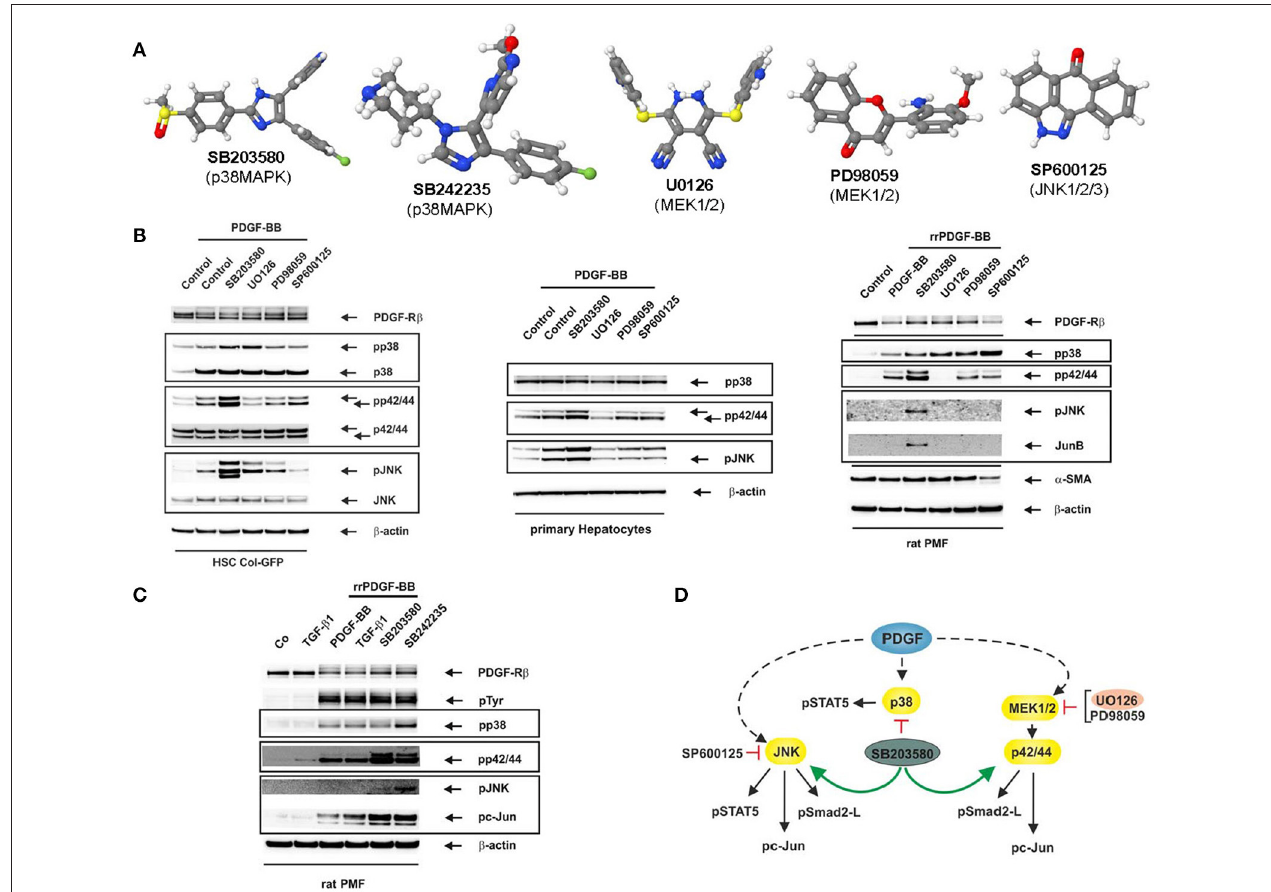
FIGURE 1 | Reciprocal activation of MAPK signalling by MAPK inhibitors. (A) Images of inhibitors used in this study were generated with software Jmol (version 14.2.15). (B) The reporter cell line HSC Col-GFP (left), primary hepatocytes (middle) and (activated) PMF (right) were stimulated for 10min with PDGF-BB (25ng/ml) after pre-incubation of cells with the indicated inhibitors (each 10 µ M) for 1h. Thereafter, proteins were extracted and subjected to Western blot analysis with the depicted antibodies. The inhibition of MAP kinases impacts PDGF responses as PD98059 and UO126 reduce pp42/44 phosphorylation. In addition, SP600125 blunts c-Jun activation, while SB203580 and SB242235 reduce STAT5 phosphorylation (data not shown). (C) Rat PMF were stimulated for 10min with TGF- β 1 (1ng/ml) or PDGF-BB (25ng/ml) after pre-incubation of cells with the depicted p38 inhibitors (each 10 µ M) for 1h. (D) Deduced impact of inhibitors on MAP kinase activity in cultured HSC Col-GFP. Antibodies used are from Santa Cruz (PDGF-R β , sc-432), Cell Signaling (pp42/pp44, CS-9101; p42/p44, CS-4696; pSAPK/JNK, CS-9251; SAPK/JNK, CS-9252; pc-Jun, CS-9261; JunB, CS-3753), BD Biosciences (pp38, 612288; p38, 612168), Millipore (pTyr, 05-321), Cymbus Biotechnology ( α -SMA, CBL 171), and Sigma ( β -actin, A5441), respectively. In this scheme, PDGF stands for